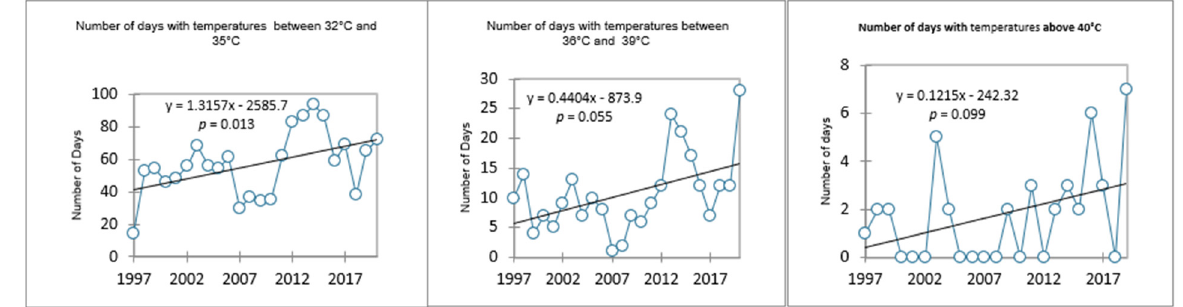
Figure 4. The trend in the number of hot and extremely hot days in Hluhluwe.